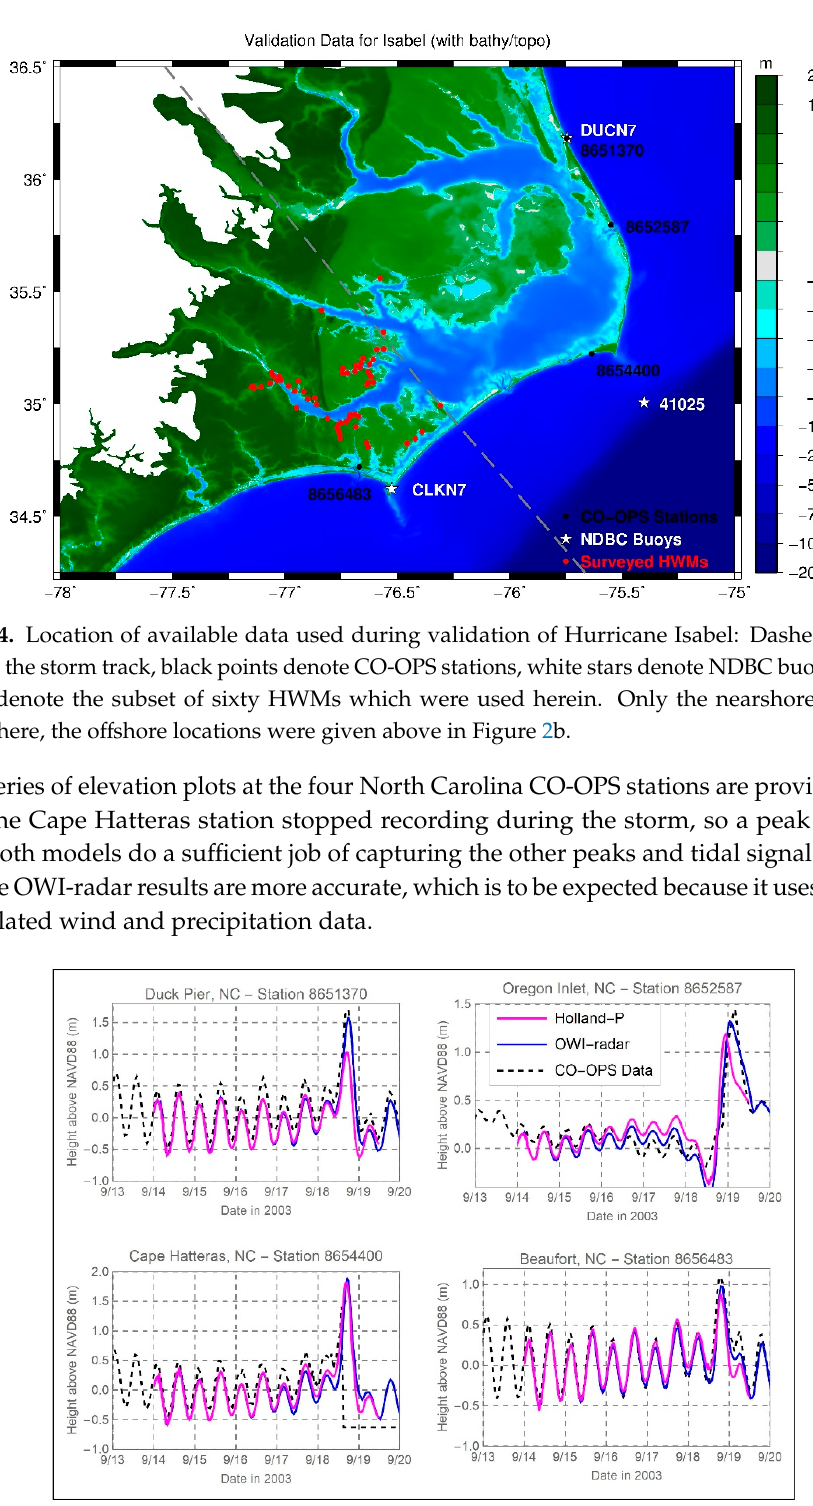
Figure 5. Elevation time series at the four North Carolina CO-OPS stations during Hurricane Isabel.